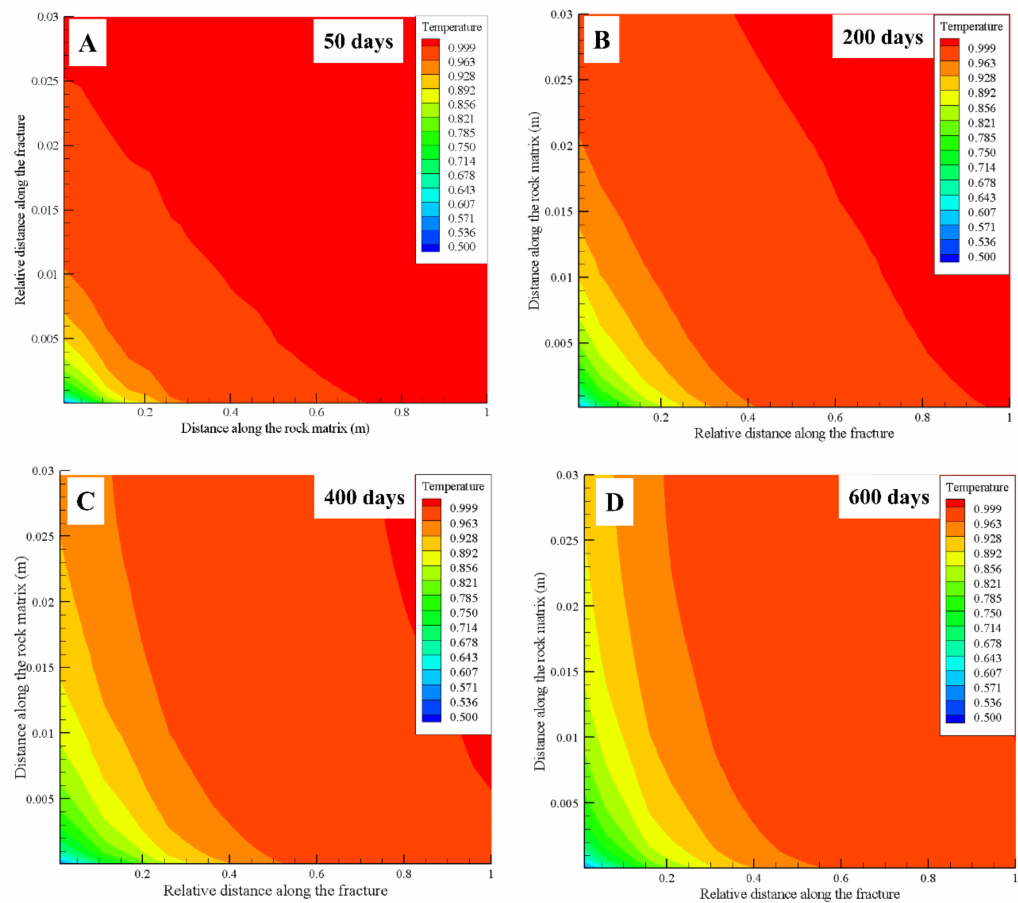
Figure 5. Contour representing the relative temperature variations in the rock matrix for the LCG-aperture model at 50 ( A ), 200 ( B ), 400 ( C ), and 500 ( D )